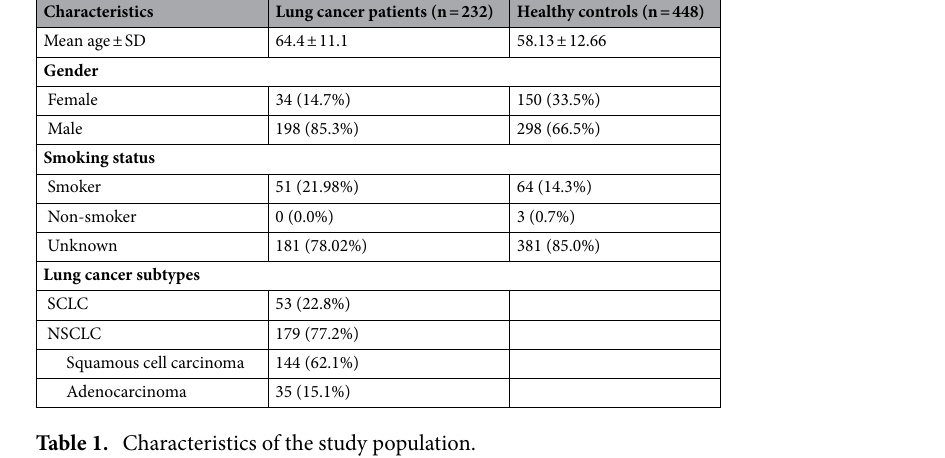
Table 1. Characteristics of the study